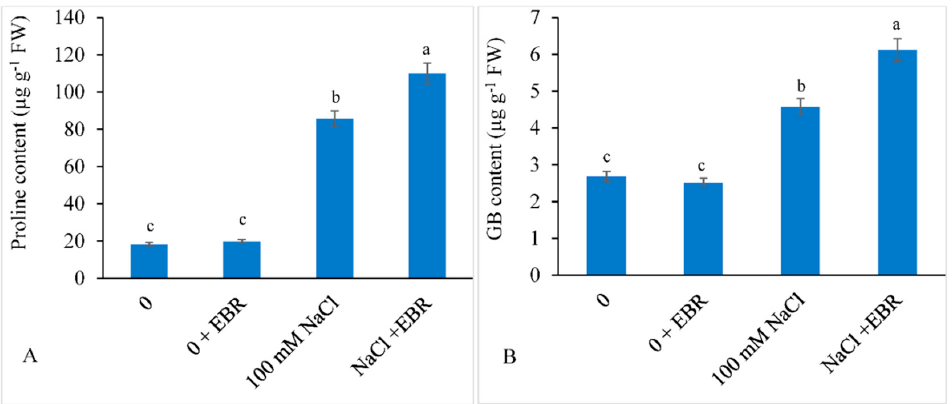
Figure 4. Exogenously applied 24-epibrassinolide (EBR) enhanced the proline ( A ) and glycine betaine (GB) ( B ) content in soybean under NaCl stress. Data presented are the means ± SE ( n = 5) and significant difference between the means calculated at p ≤ 0.05 using the Duncan’s multiple range test.